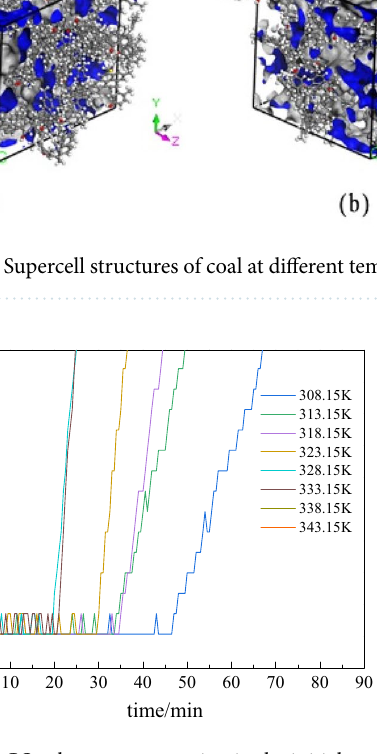
Figure 4. CO release concentration in the initial stage of the experiment.